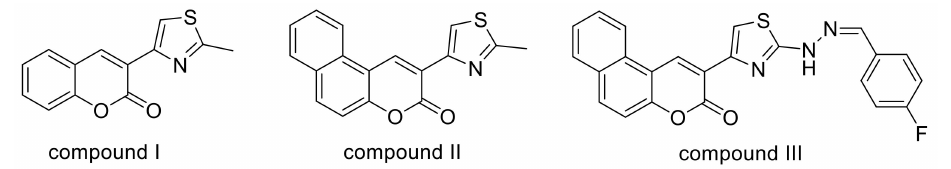
Figure 22. Structures of the synthesized coumarin thiazole derivatives.